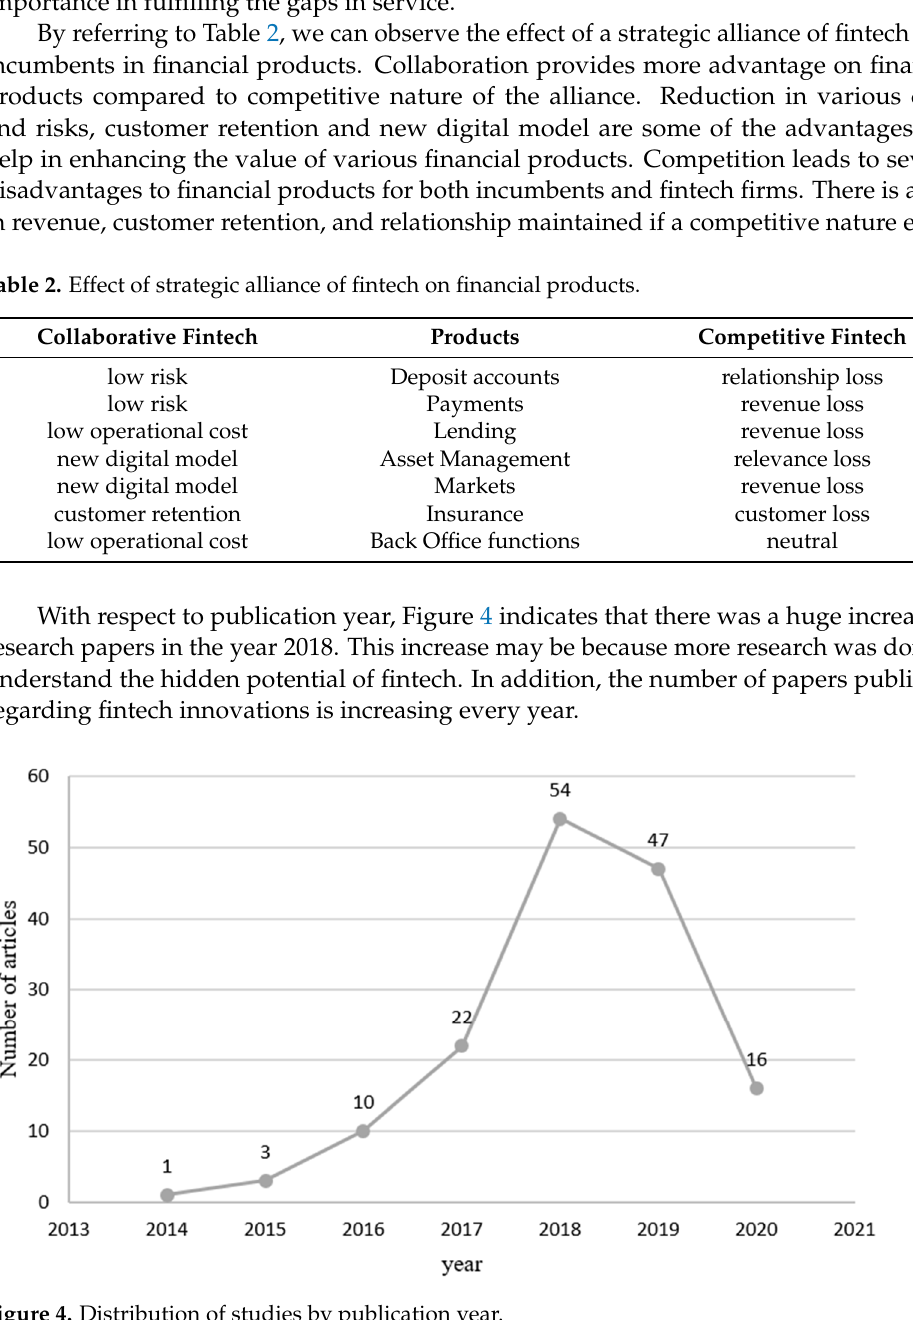
Figure 4. Distribution of studies by publication year.